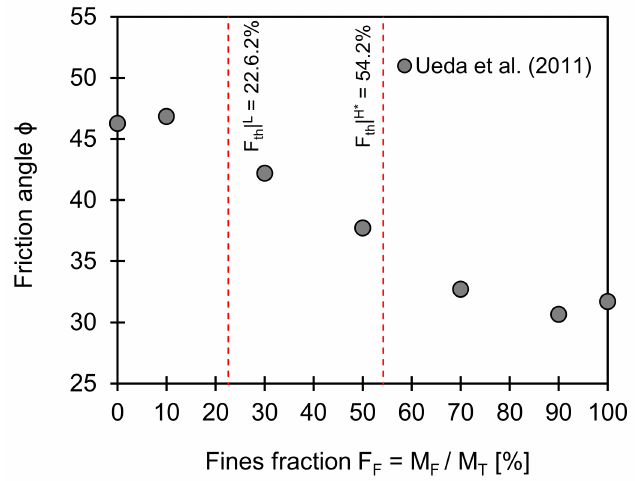
Figure 4. Friction angle versus fines fraction. Two red dotted lines indicate low and data-adjusted high-threshold fines fractions computed using Equations (2) and (4). Input parameters used for estimation of two boundaries are e C max = 0.737, e C min = 0.548, e F max = 0.879; e F min = 0.56, and F th | L = 22.6%, and F th | H * = 54.2%. Note: Data extracted from Ueda et al. [32].